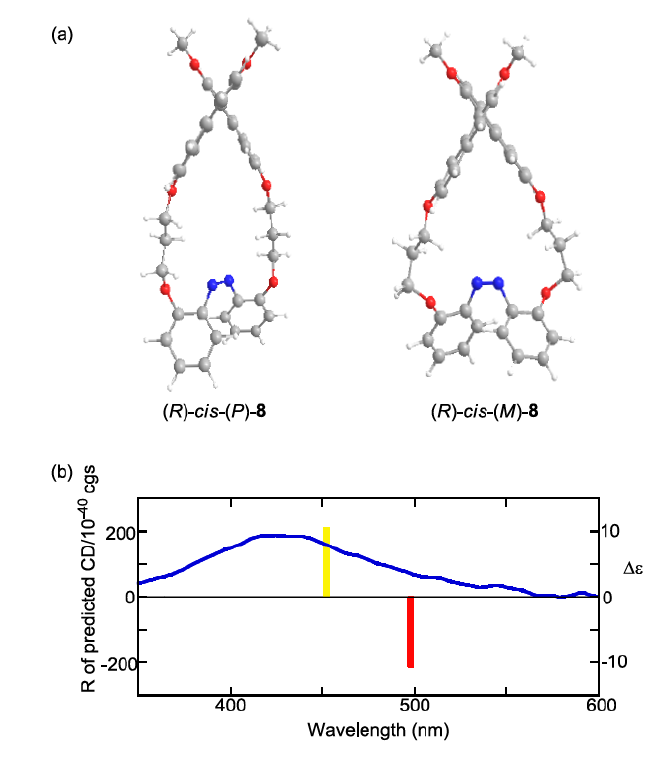
Figure 13. (a) Optimized structures of ( R )- cis -( P )- 8 and ( R )- cis -( M )- 8 obtained by the symmetry. (b) CD calculated by DFT calculations at the B3LYP/6-31G(d) level under C 2 the TD-DFT method with the B3LYP/6-31G(d) level of ( R )- cis -( P )- 8 (red bar), ( R )- cis - ( M )- 7 (yellow bar), and experimental CD of ( R )- 8 after 365-nm irradiation (blue line, 1 × 10 − 5 M in 1,4-dioxane, 20 ° C).